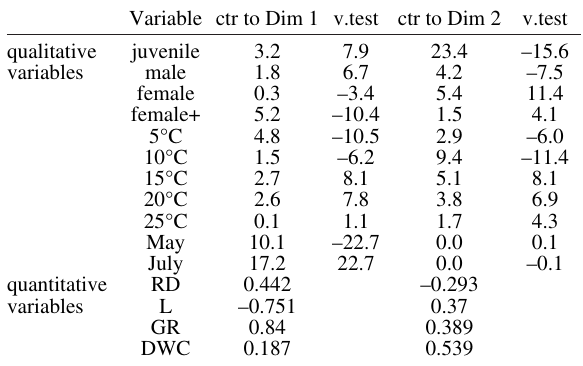
panels).Table 2. – Values obtained from the generalized additive model Table 1. – Results of the factorial analysis of mixed data. Upper used in Analysis 2: Nonlinear additive effects of variables. Table parts shows the results for qualitative variables, the lower part for includes the number of knots k’, estimated degree of freedom (edf), the quantitative variables. For both sets of variables their contribu- k-index and the significance value p. tion to dimension 1 and 2, and for the qualitative variables also the results of the v.test.